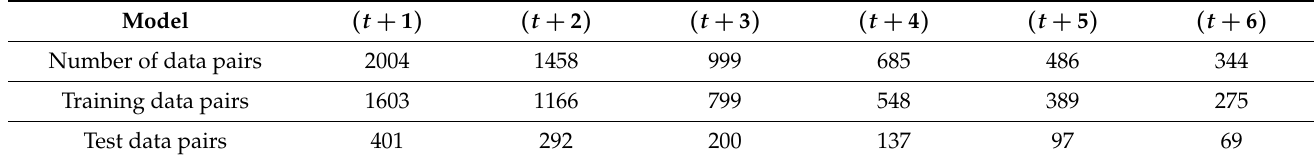
Figure 2. Histogram of the reference track length. Table 1. The number of learning data pairs for each model (Training:Test =